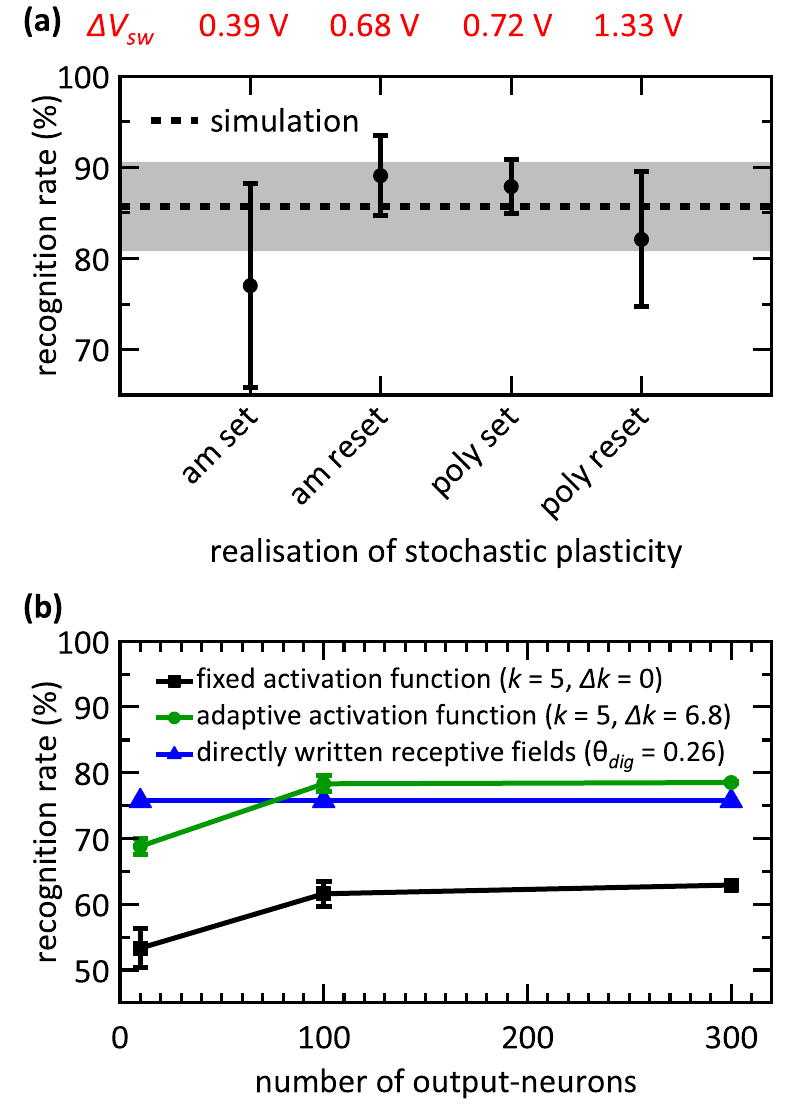
Figure 7. Recognition rates of the StochANN. ( a ) Shows the combination of the experimental results for MNIST subsets {0, 1, 9} and {0, 3, 8}. Depicted are mean values and standard deviations of five experimental runs for each pattern (i.e. ten runs in total for each data point). The mean value of 100 simulation runs for each pattern set is depicted as dashed line while the standard deviation is depicted as grey area, respectively. Five learning epochs are used in every simulation run. While the abbreviations “poly” and “am” denote the polycrystalline and the amorphous HfO 2−x based devices, “set” and “reset” denote the transition used to emulate stochastic plasticity. In ( b ) the simulation results for the whole MNIST test set are shown. These results are obtained with a fixed activation function of the output-neurons (black squares) and an adaptive activation function (green circles). The mean values and standard deviations of five runs with five learning epochs are depicted. The direct written receptive fields are shown for comparison (blue triangles). Here, no stochastic mechanisms are involved. Thus, no standard deviation can be denoted. Moreover, an increasing amount of output-neurons does not increase the recognition rate for the latter method, as only one prototype of each pattern can be